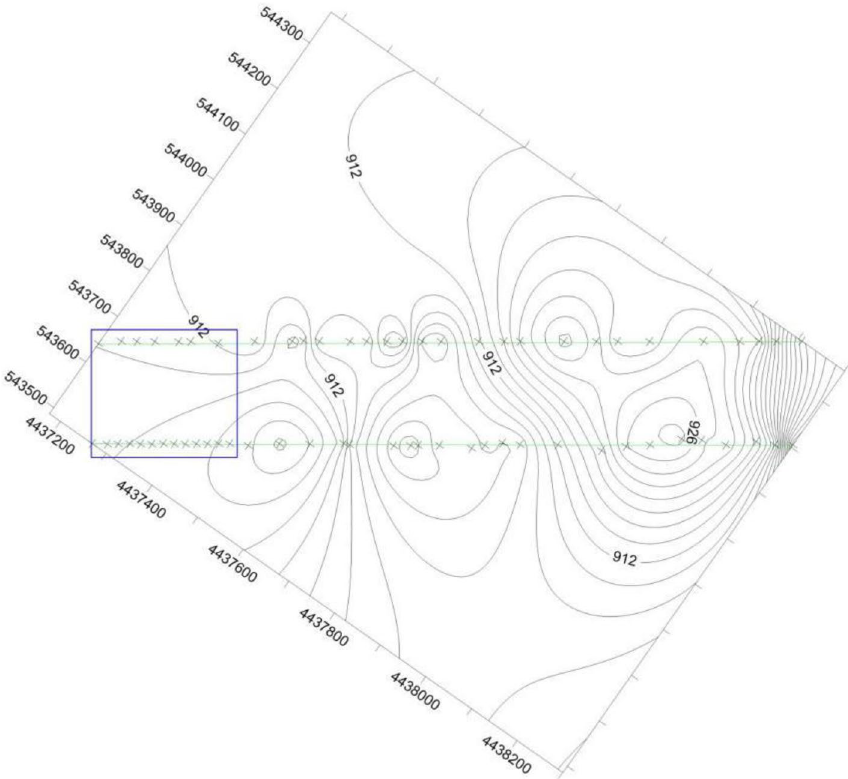
Figure 5. The elevation of points that enclosed by blue rectangle are calculated by Kriging method.